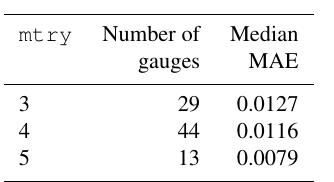
Table 3. The optimized parameter mtry using an exhaustive search strategy ( mtry = {1, 2, 6, 7, 8} was considered but not found to be the optimal value at any